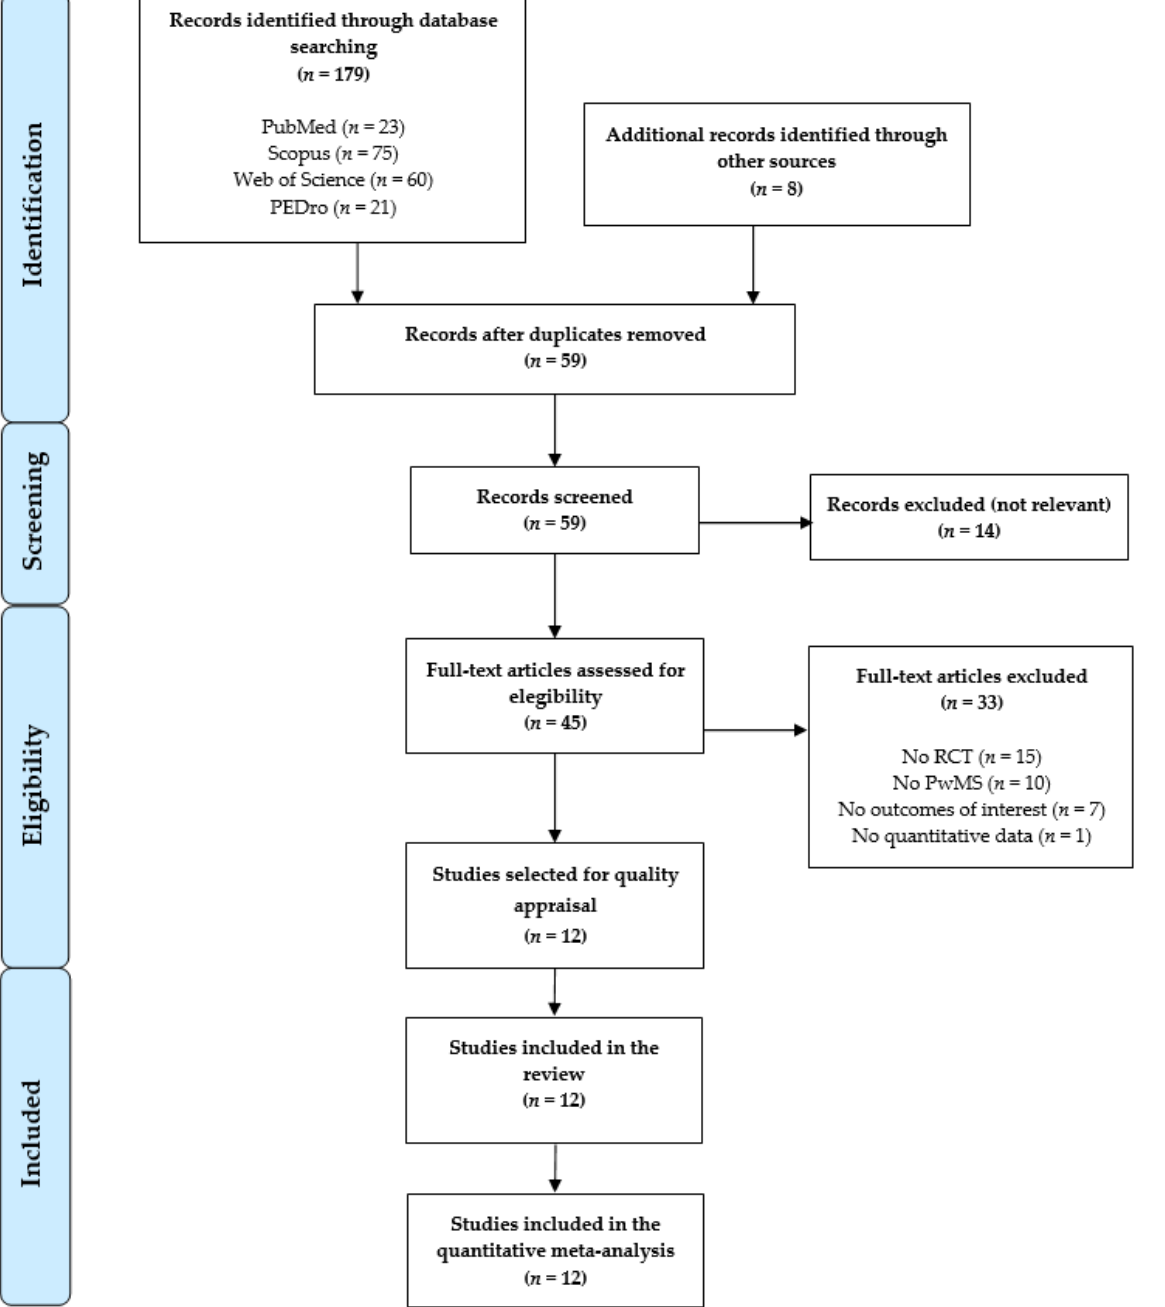
Figure 1. PRISMA (Preferred Reporting Items for Systematic Reviews and Meta-Analyses) flow chart for study Table 2. Characteristics of the Studies Included in the Review.